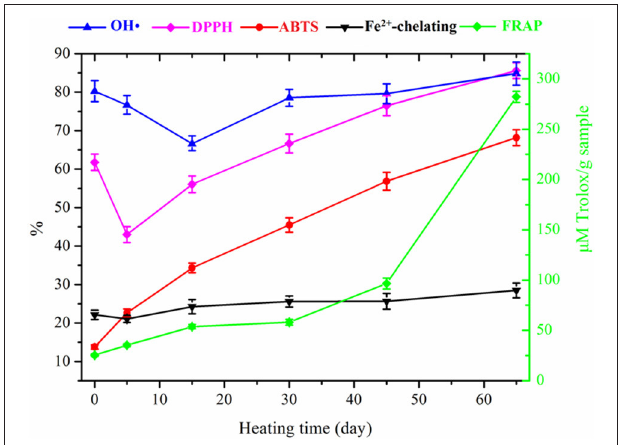
FIGURE 5 | Changes in antioxidant activities of apple during 65-day HTFP process.